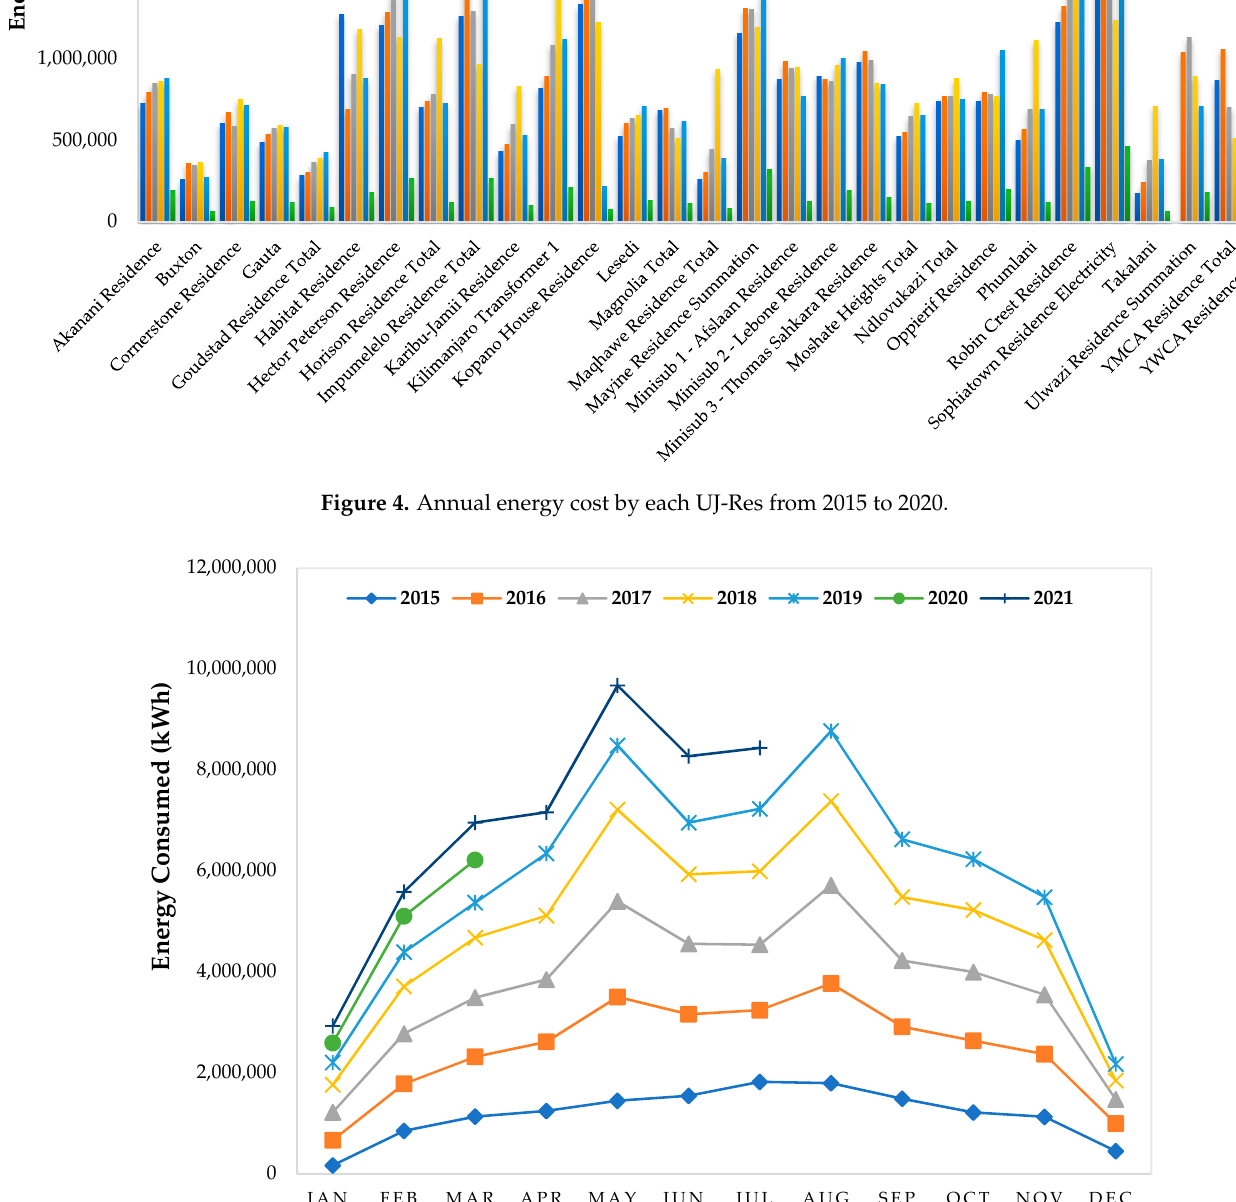
Figure 6. UJ-Res total monthly energy cost (in ZAR) from January 2015 to July 2021. 5. Discussion 5.1. Training, Testing, and Validation of Energy Data with NARX-NN To have an effective prediction, a MATLAB non-linear autoregressive exogenous neural network ( NARX-NN ) time-series toolbox model was used to train the energy da- taset. The monthly EC from January 2015–July 2021 (71 data points) was employed as the